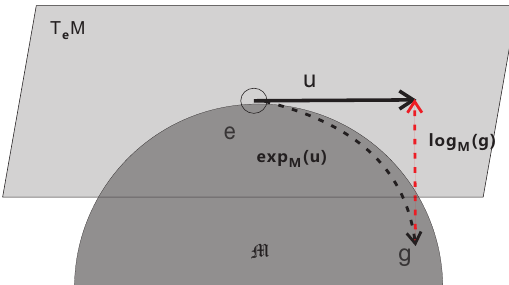
Figure 9. Illustration of the exponential and the logarithmic maps. The example point of g on the manifold is mapped to a point on the tangent plane T e M using a logarithmic map Log M p g q . M The exponential map exp M p u q is the reverse of the logarithmic